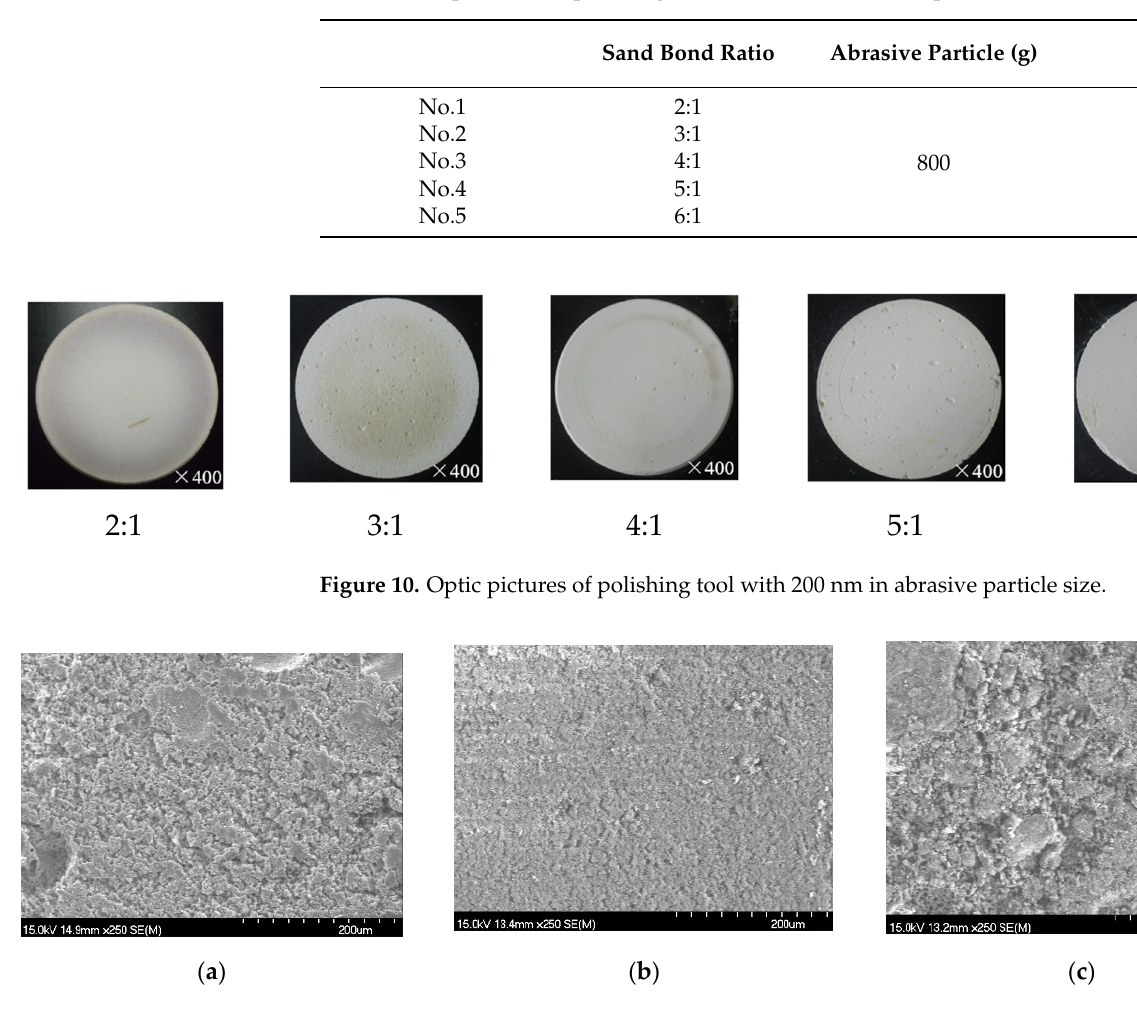
Table 5. Compositions of polishing tool with 200 nm abrasive particles.